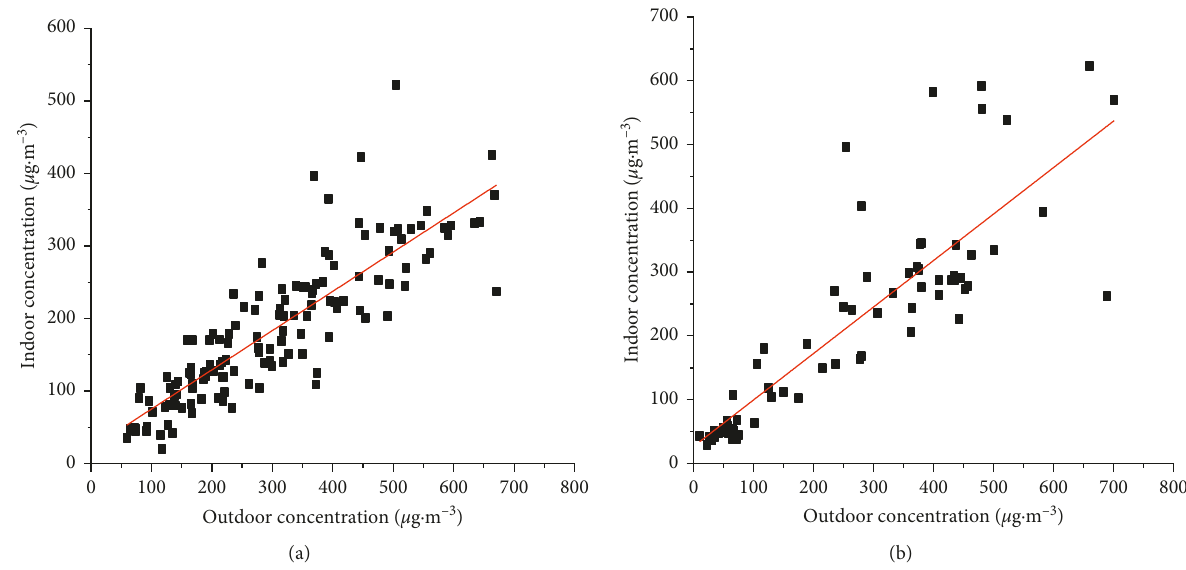
Figure 8: The relationships between the indoor PM2.5 concentrations and the outdoor PM2.5 concentrations: (a) summer; (b)